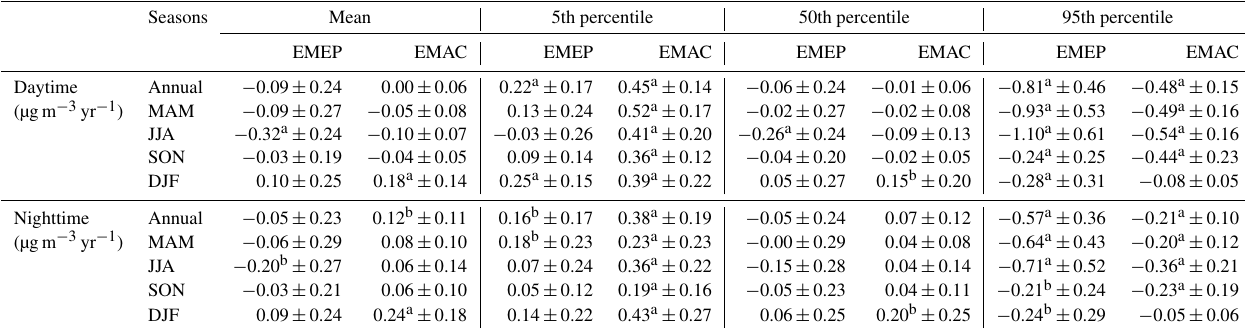
Table 3. Modeled and observed linear trends ∗ and their spatial standard deviations of the 1995–2014 European mean annual and seasonal averaged daytime and nighttime mean, as well as their 5th, 50th, and 95th percentile ozone concentrations (averaged over the 93 sites).